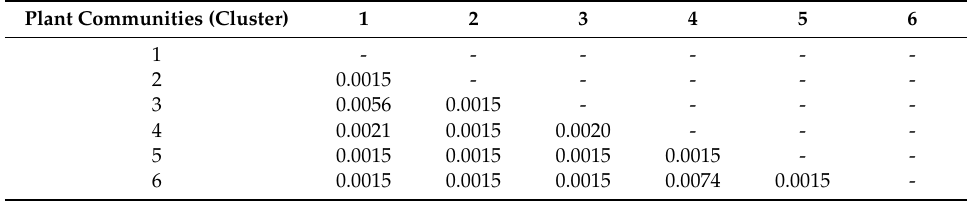
Table A2. Permutational multivariate ANOVA (PERMANOVA) results for pairwise comparisons to test for di ff erences in NDVI seasonality (FPCA scores) among plant communities. Significant adjusted p -values in bold ( α =